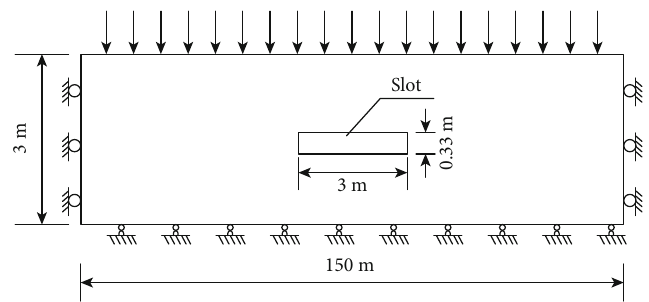
Figure 4: Schematic diagram of the calculation model.